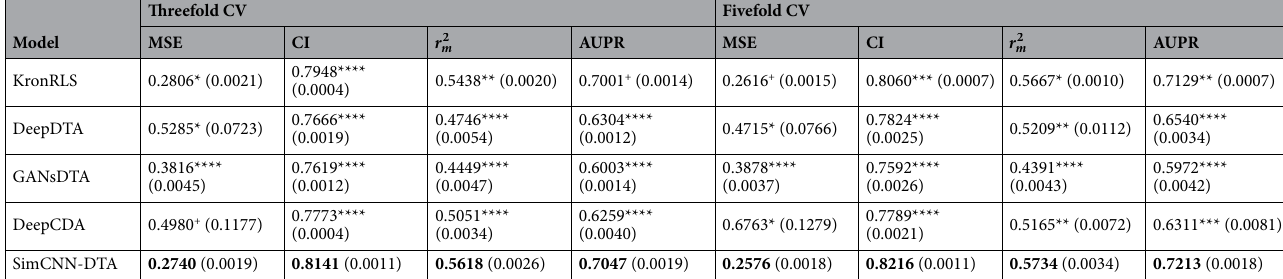
Table 3. Comparison of five prediction models via threefold and fivefold cross validations on the KIBA